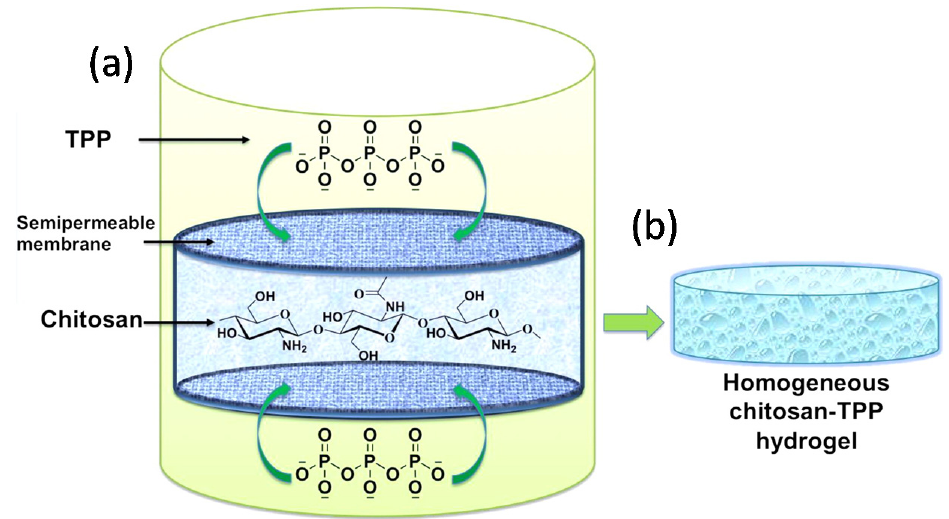
Figure 11. ( a ) Experimental setup for developing chitosan-tripolyphosphate (TPP) macroscopic gels through external gelation method. ( b ) Scheme of the obtained homogeneous chitosan-TPP hydrogel. Reprinted with permission from ([13], 2014 American Chemical Society).